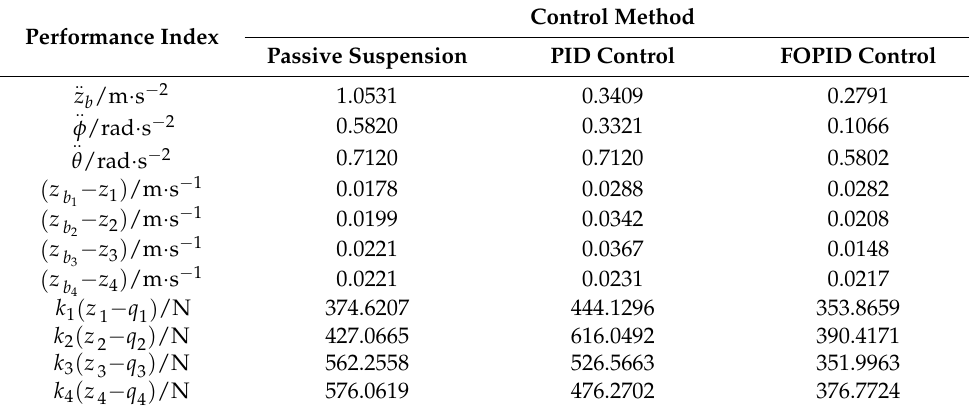
Table 4. Table of root mean square values of performance